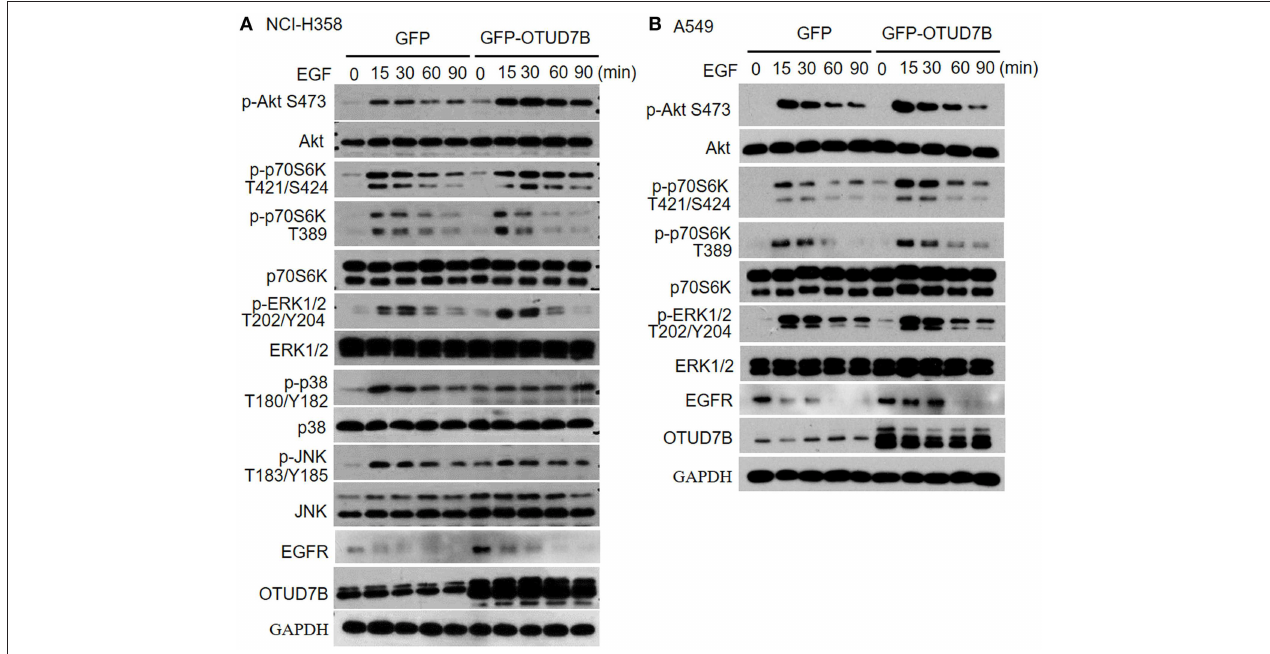
FIGURE 3 | OTUD7B activates Akt and ERK1/2 signals in NSCLC cell lines. NCI-H358 cells (A) or A549 cells (B) transduced with GFP or GFP-OTUD7B were stimulated with EGF (500ng/ml) for indicated times and total cell lysates were harvest and subjected to immunoblotting assay. and performed MTT cell proliferation assay. As expected, ( Figure 2A